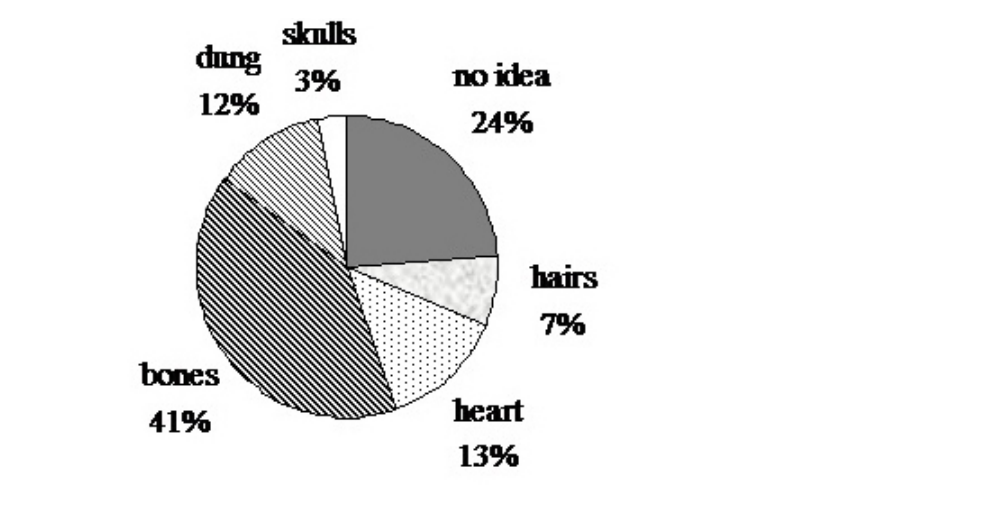
Fig. 3. Gorilla body parts reported as ingredients for traditional medicine in five villages of Lebialem Division (percentage of all